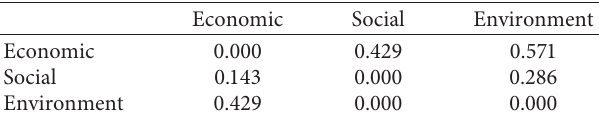
Table 24: Normalized matrix of sustainability dimensions in de- terministic condition.